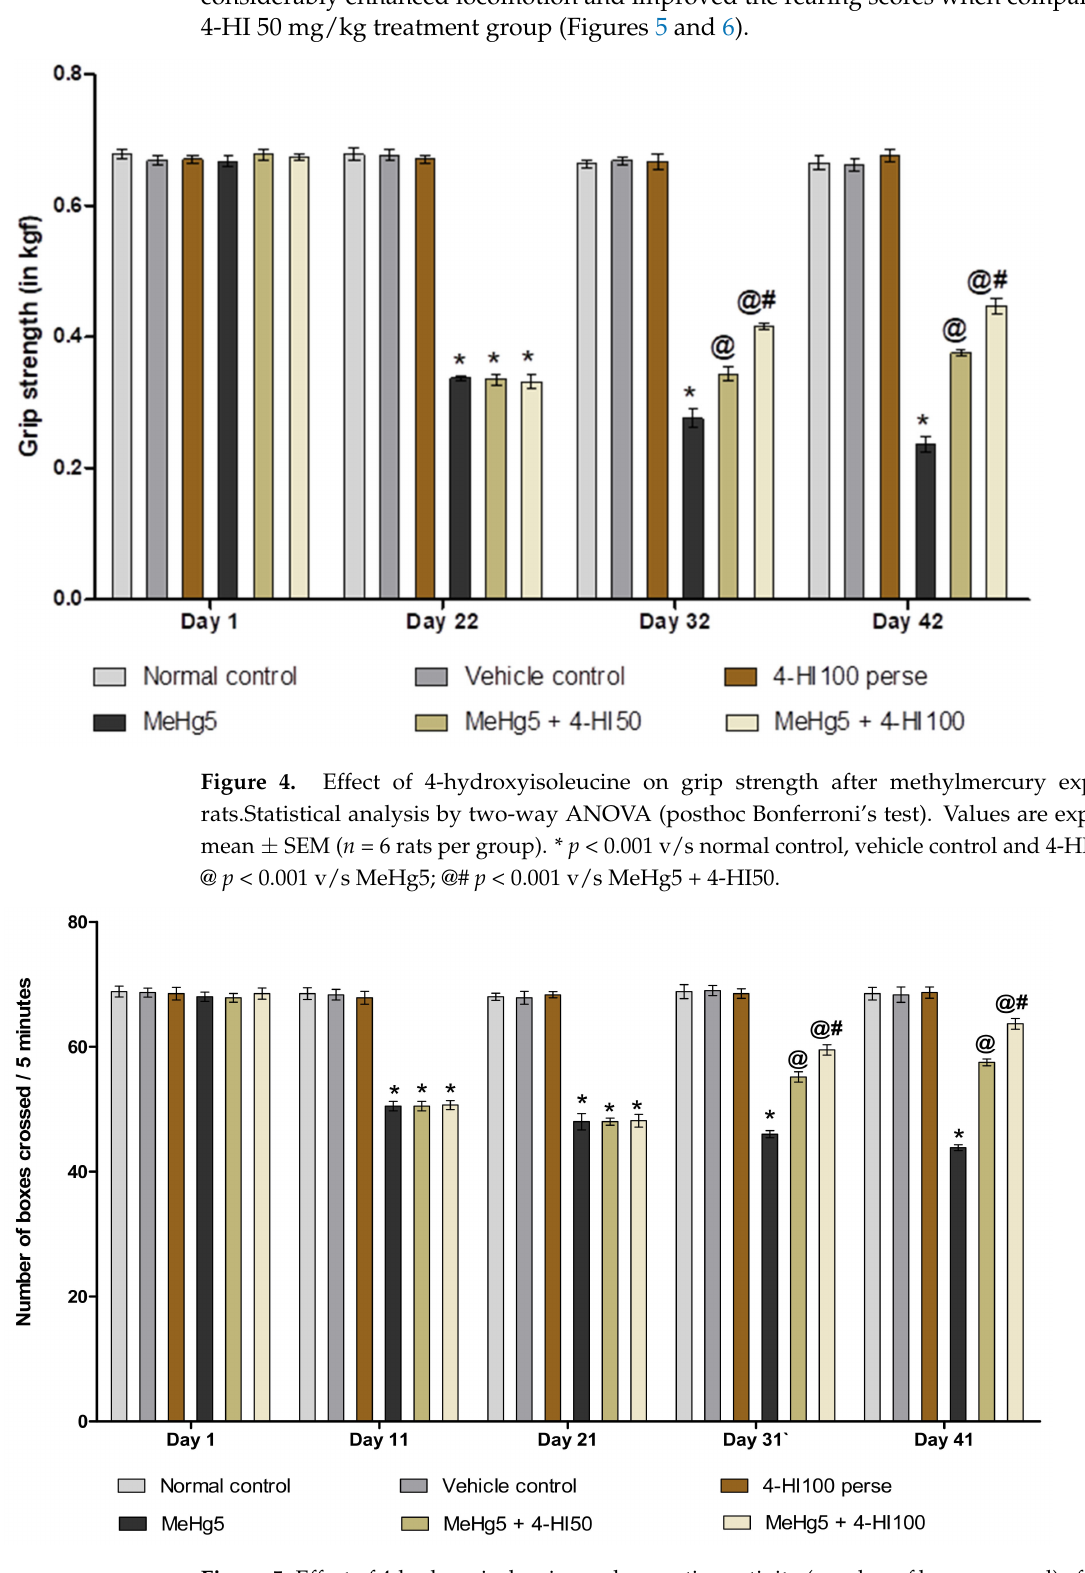
Figure 5. Effect of 4-hydroxyisoleucine on locomotion activity (number of boxes crossed) after methyl mercuryexposure in rats. Statistical analysis by two-way ANOVA (posthoc Bonferroni’s test). Values are expressed as mean ± SEM ( n = 6 rats per group). * p < 0.001 v/s normal control, vehicle control and 4-HI100 perse ; @ p < 0.001 v/s MeHg5; @# p < 0.001 v/s MeHg5 +